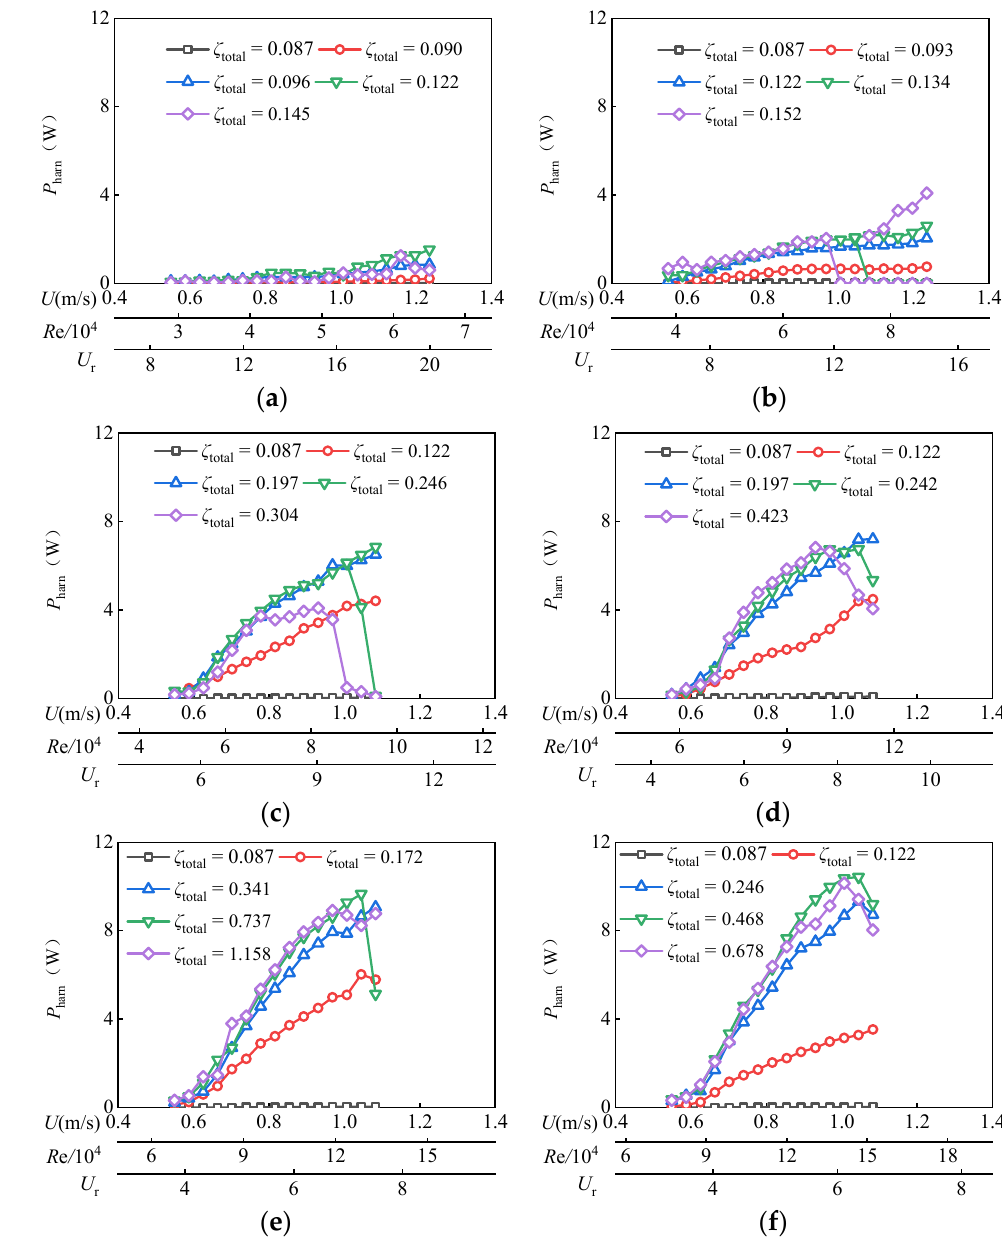
Figure 18. Active power of Cir-T-Att. ( a ) D = 0.06 m, Re = 2.89 × 10 4 ~6.51 × 10 4 . ( b ) D = 0.08 m, Re = 3.86 × 10 4 ~9.21 × 10 4 . ( c ) D = 0.10 m, Re = 4.82 × 10 4 ~1.15 × 10 5 . ( d ) D = 0.12 m, Re = 5.79 × 10 4 ~1.38 × 10 5 . (e) D = 0.14 m, R e = 6.75 × 10 4 ~1.61 × 10 5 . ( f ) D = 0.16 m, R e = 7.71 × 10 4 ~1.84 × 10 5 .